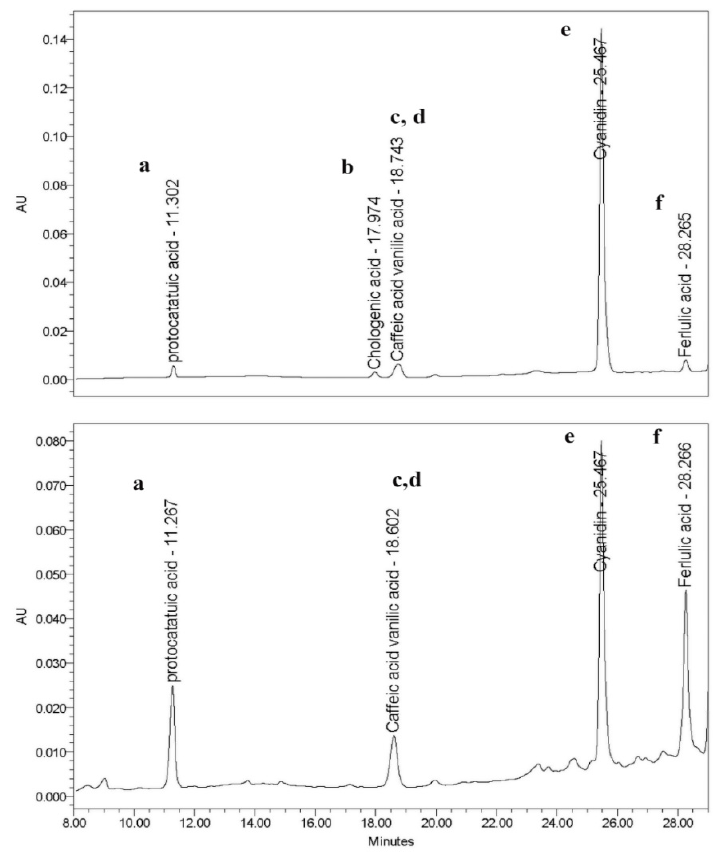
Figure 1. Chromatograms (HPLC/UV) of the fruit extract of A. thwaitesianum . The upper figure shows the control compounds, whereas the lower figure shows the active compounds present in the extract. The retention time of the flavonoids was shown as follows: (a) protocatechuic acid, (b) chlorogenic acid, (c) caffeic acid, (d) vanillic acid, (e) cyanidin, and (f) ferulic acid. Compared with the standard compound, the A. thwaitesianum fruit extract found five active substances compared to the standard compounds.